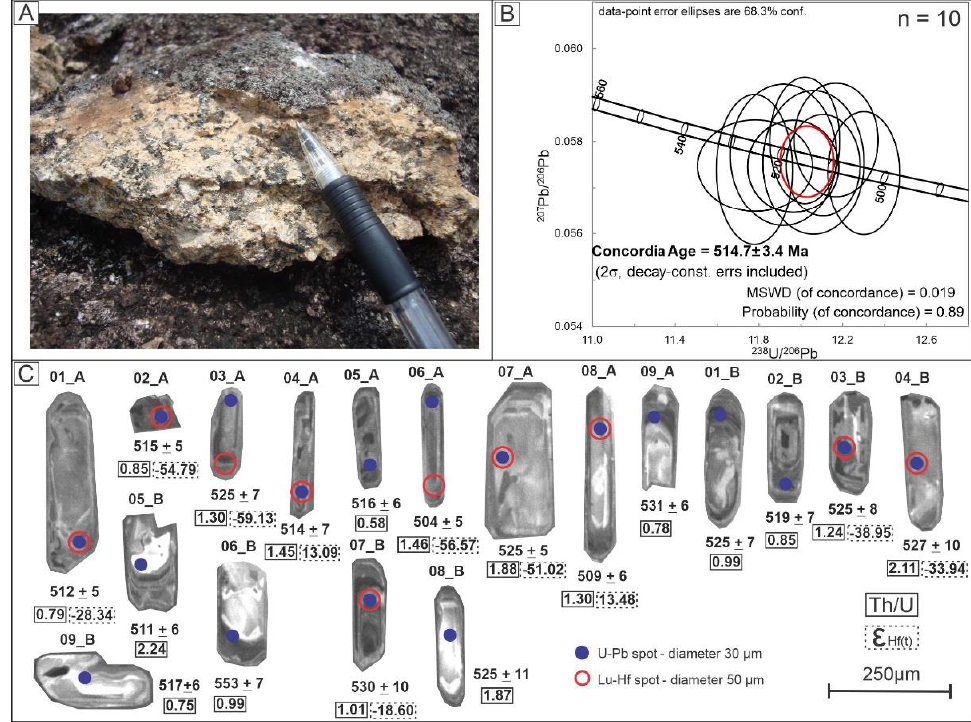
Figure 9. ( A ) A representative sample of the SAIC felsic hybrid rock from the point SAIC-10. ( B ) Concord age for the sample SAIC-10A. ( C ) Cathodoluminescence image of the analyzed zircon grains.